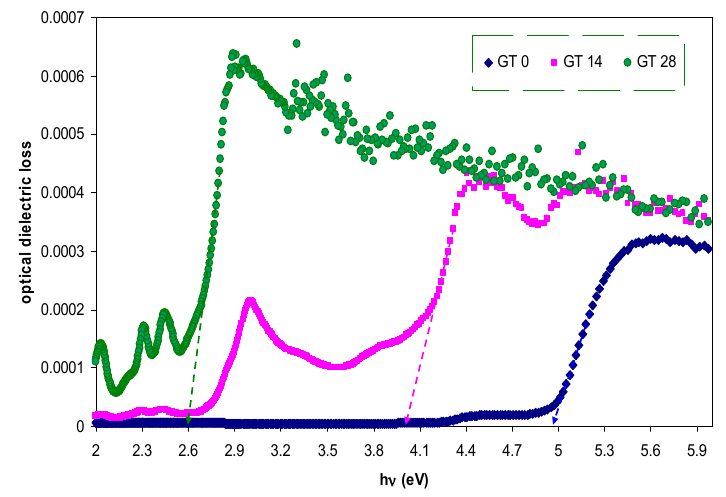
Figure 11. Optical dielectric loss spectra for pure and doped PMMA samples.